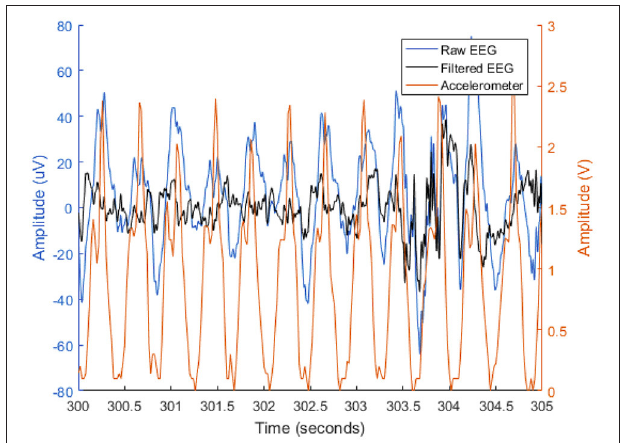
FIGURE 5 | Time representation of a 5-s EEG segment from electrode AF8 before (blue) and after (black) adaptive filtering. The L2-normalization of the x, y, and z accelerometry axes is represented in